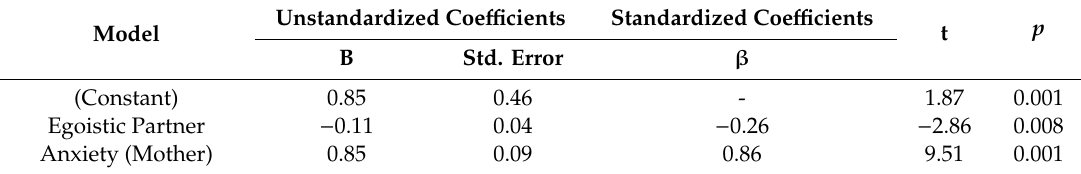
Table 8. Final model coefficients for predicting anxiety in regard to close relationships with the partner *.